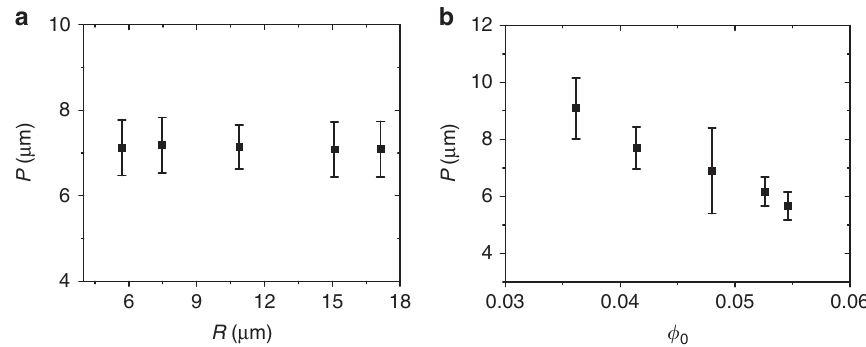
Figure 4 | Structural characteristics of the droplets with bipolar patterns. ( a ) Variation in pitch, plotted as a function of droplet radius R . f 0 ¼ 0.048. ( b ) Pitch variation as a function of CNC volume fraction in the droplets. For each experimental point, at least, 30 droplets were analysed. The error bars represent